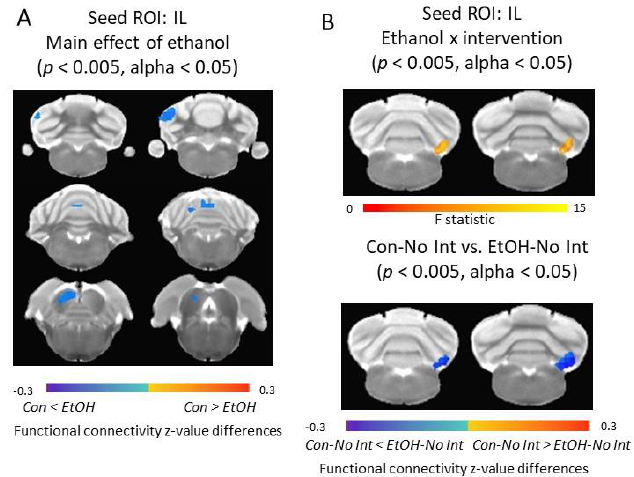
Figure 5. Alterations of IL functional connectivity in male rats. (A) Main effect of ethanol was detected in the external cortex of the inferior colliculus and cerebellar areas. Color code: connectivity differences between Con and EtOH animals. (B) The ethanol x intervention effect was detected in the paramedian lobule and copula pyramidis area. Color code: top panel – F statistics of the two-way ANOVA analysis; bottom panel - connectivity differences between Con-No Int and EtOH-No Int animals. ROI=Region of Interest; IL=infralimbic cortex; Con=Control, EtOH=Ethanol, No Int=No Intervention.